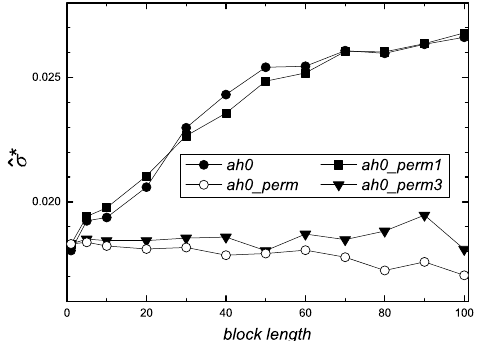
Figure 5 – Moving Block Bootstrap estimates ˆ σ ∗ of the standard error of p as a function of the block length l , for the hidden ( ah0 , full circles) codon classes, computed with no frame shift for the anticodon sequence U53218 (coding region), with n = 739. Results obtained by applying the MBB to the same codon class, but with the original DNA base sequence randomly permuted are reported in empty circles ( ah0_perm ), as in Figure 4. Results with only the first base permuted ( ah0_perm1 , full squares), with only the third base permuted ( ah0_perm3 , full triangles) are also